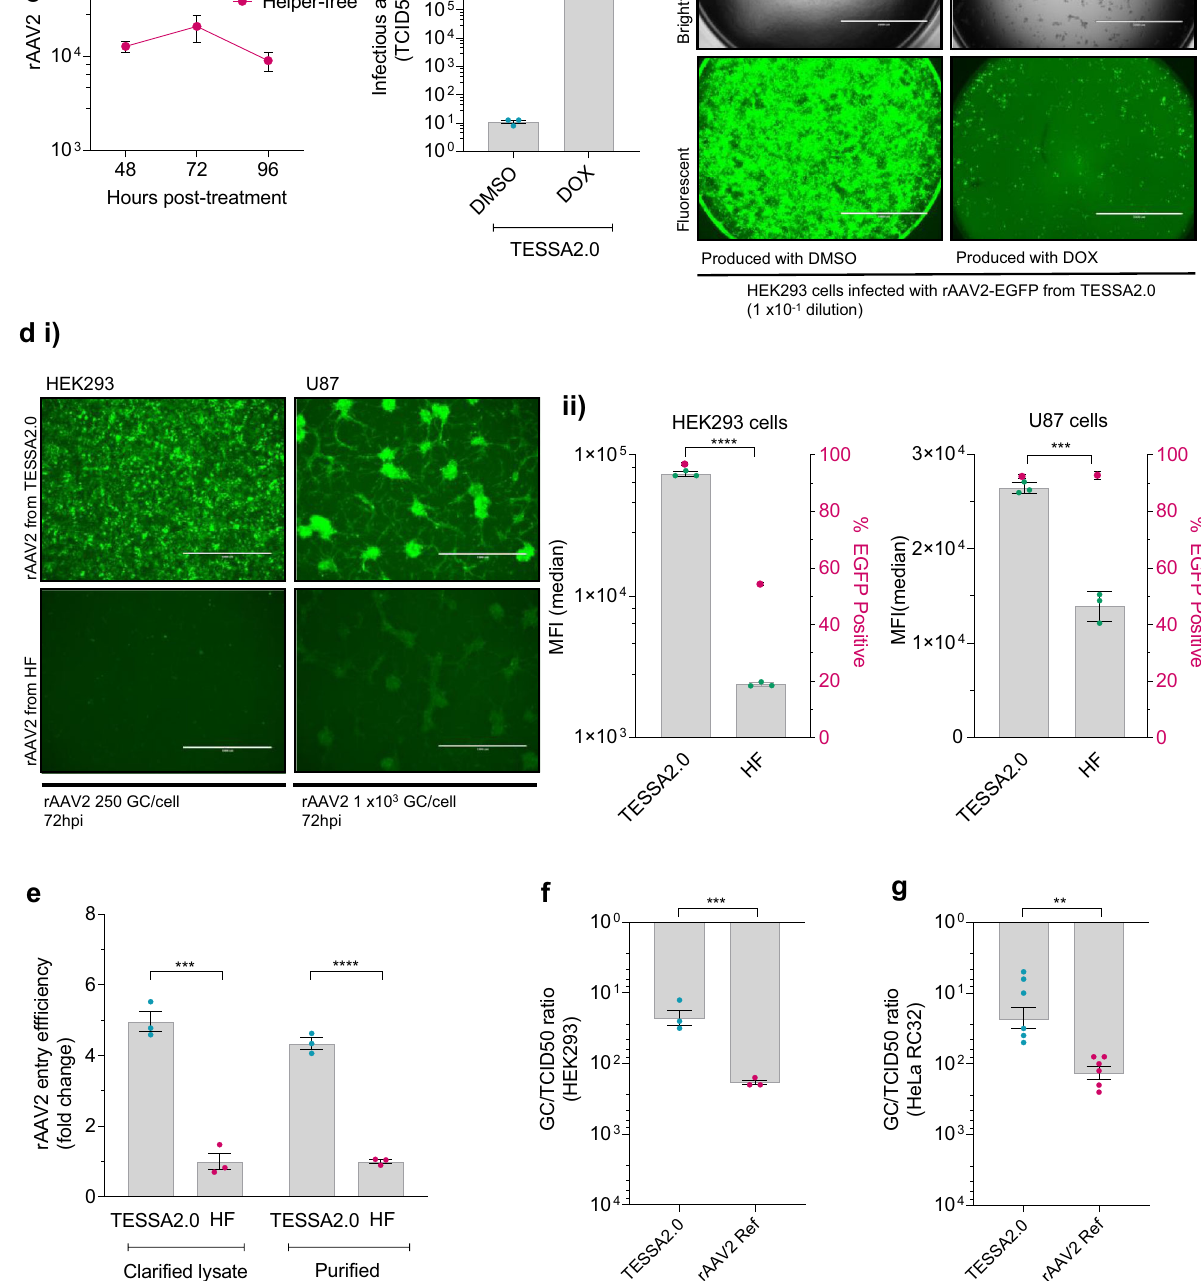
in puri fi ed stocks (via AAVX Af fi nity Resin) of rAAV2 produced in suspension HEK293 cells using TESSA2.0 compared to a commercial rAAV2 reference standard (Supplementary Fig. 5c). Analysis of TESSA2.0-derived rAAV2 by transmission electron microscopy (TEM) showed the expected AAV morphology, indistinguishable from HF-derived particles, and no evidence for any adenovirus contamination (Supplementary Fig. 5d). We also measured adenovirus contamination in crude rAAV preparations